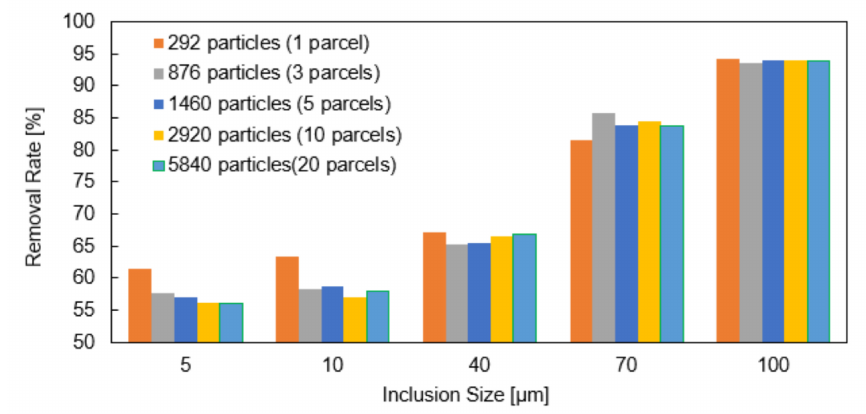
Figure 3. Comparison of inclusion removal rate obtained by di ff erent injected particle number (inclusion density: 3500 kg m − 3 ; Case 2-W + HD).